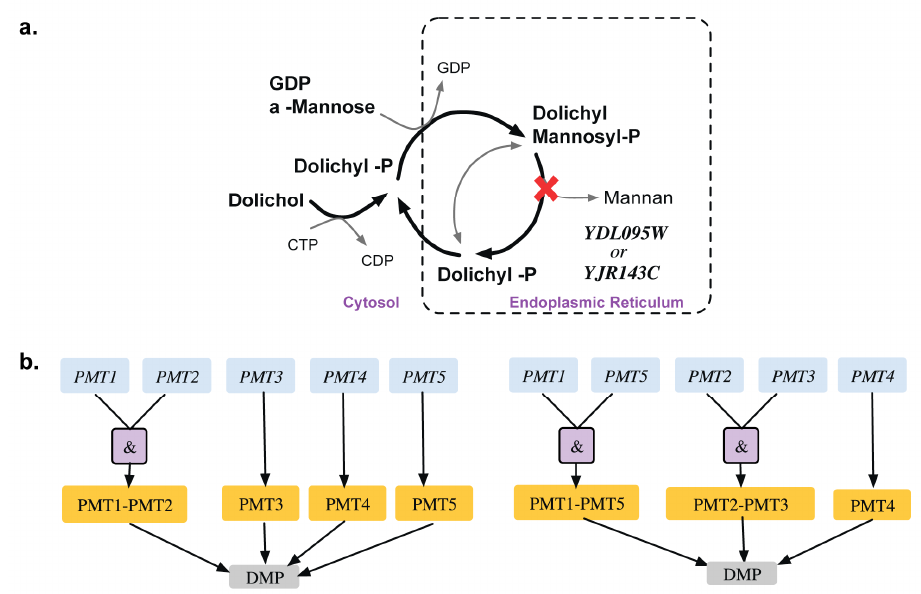
Figure 6. Auxotrophy of mannan ( a ). Pathway showing essential reaction (marked with red cross) for mannan biosynthesis ( b ). Gene-protein-reaction association for conversion of dolichyl-mannosyl phosphate to mannan. The genes (blue) code for the proteins (orange), which catalyze the reaction (gray). Old GPR is shown on the left and new GPR on the